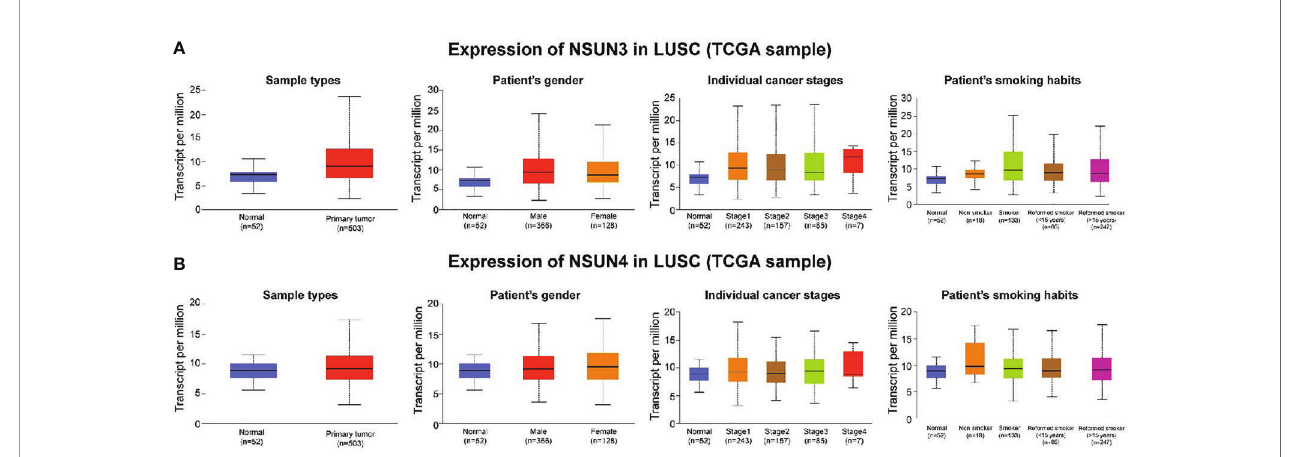
FIGURE 5 | Association between NSUN3 and NSUN4 expression and clinicopathological parameters in patients with LUSC (UALCAN). (A) Expression of NSUN3 in normal and LUSC tissues based on sample types, patients ’ gender, cancer stage, and smoking habits. (B) Expression of NSUN4 in normal and LUSC tissues based on sample types, patients ’ gender, cancer stage, and smoking habits.